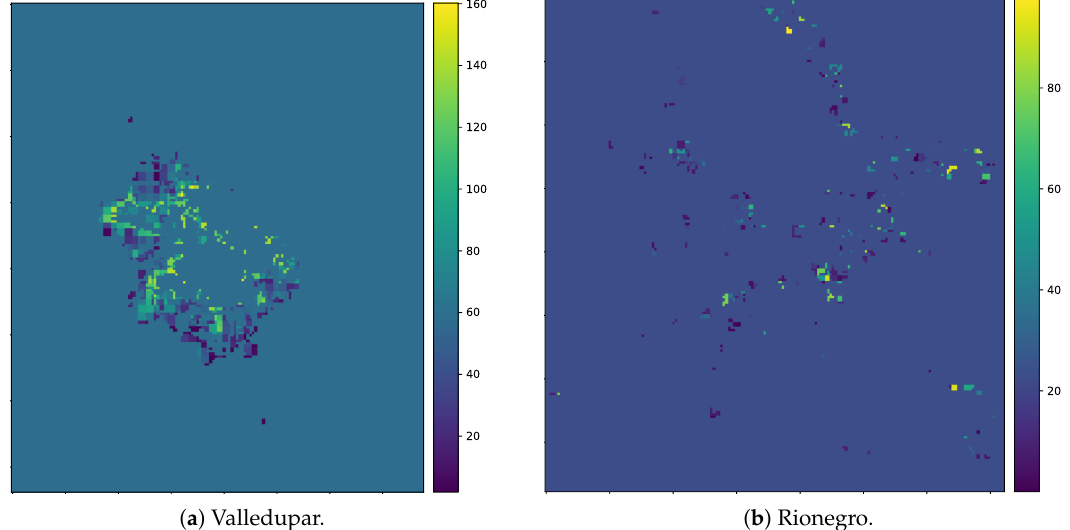
Figure 18. Maps with population thresholds beyond which non-urban pixels become urban.